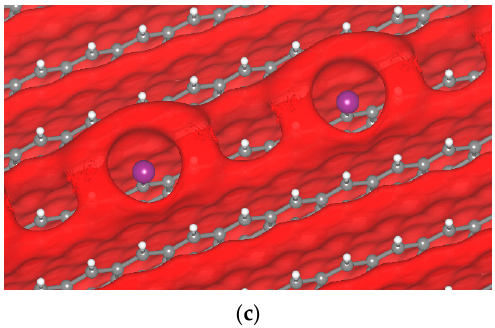
Figure 9. Passivated H-terminated (001) surface. ( a ) Crystal of passivated graphite with iodine. Isopotential surface of graphite with iodine atom, separated between negative (red) and positive (blue) regions; ( b ) graphite atomic conformation and isopotential ±2.35 V; and ( c ) graphite atomic conformation and isopotential − 2.35 V.